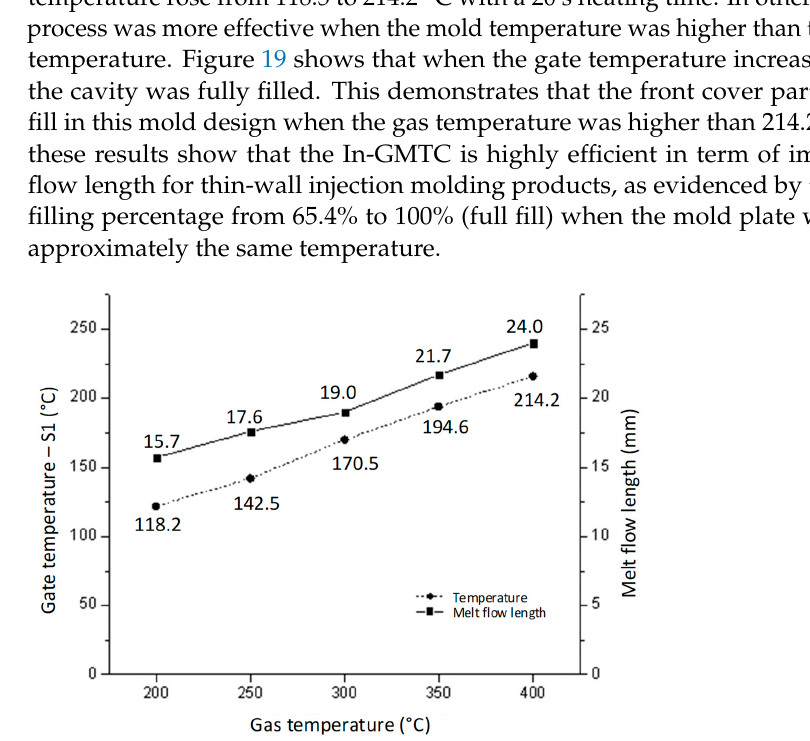
Figure 17. Temperature distribution of the core plate after 20 s of heating with gas temperatures of ( a ) 250 °C, ( b ) 300 °C, ( c ) 350 °C, and ( d ) 400 °C.